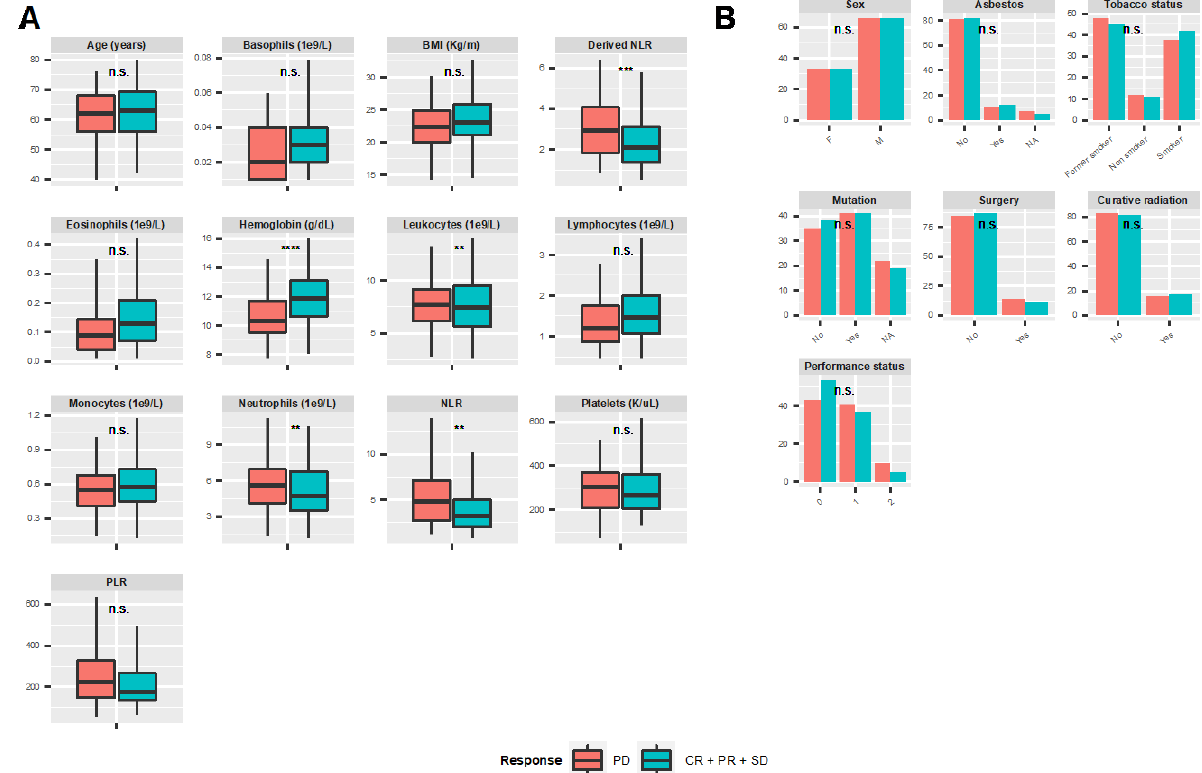
Figure 1. Exploratory data analysis. ( A ) Boxplots of continuous variables. ( B ) Barplots of categorical variables. BMI = body mass index, NLR = neutrophil-to-lymphocyte ratio, PLR = platelets-to-lymphocytes ratio, CR = complete response, PR = partial response, SD = stable disease and PD = progressive disease. Stars indicate statistical significance: **: p < 0.01, ***: p < 0.001, ****: p < 0.0001, n.s. = non-significant. Table 2. Logistic regression analysis for disease control.